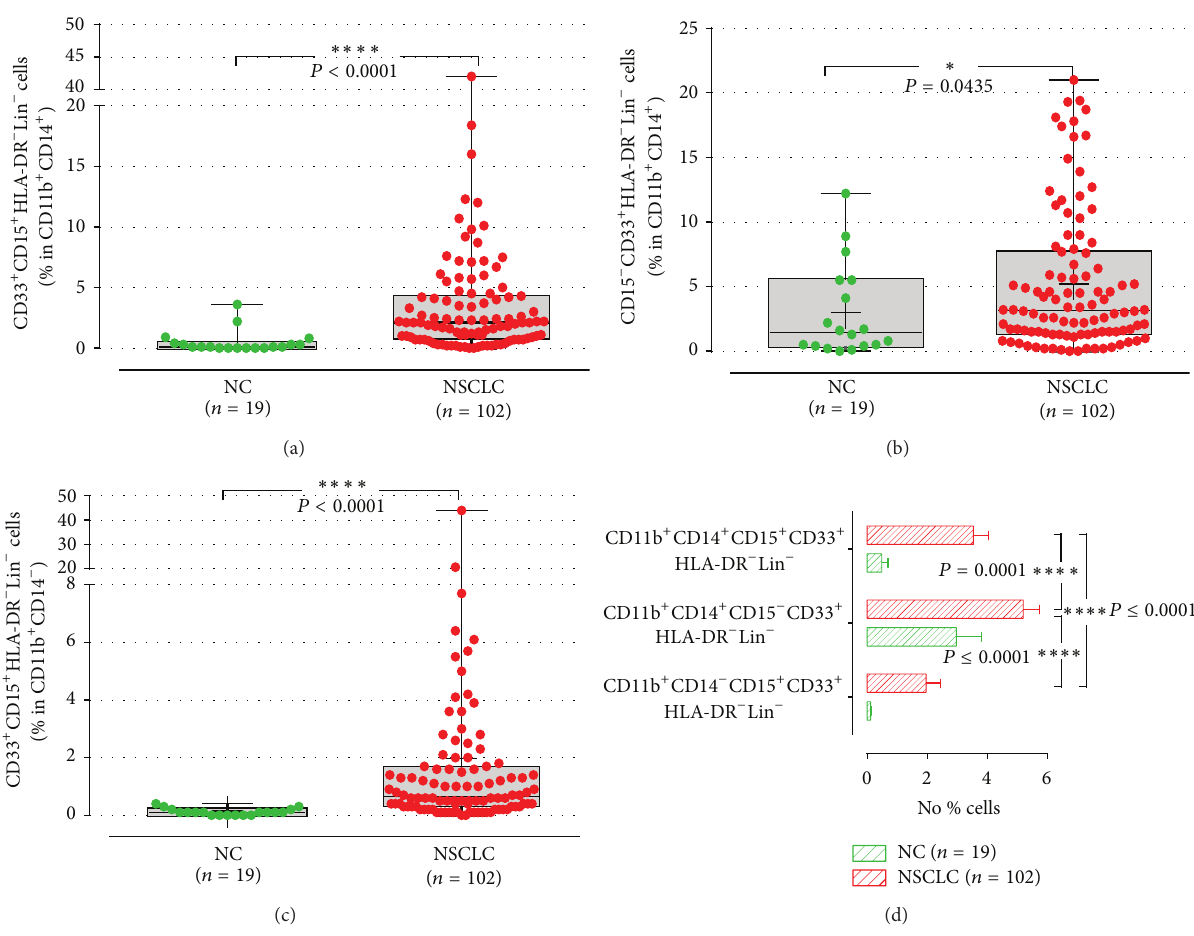
Figure2:M-MDSCandG-MDSCsubpopulationsinNSCLCpatientsandnormalcontrols.Percentageofmonocytic(a),(b),andgranulocytic (c) subpopulations of MDSCs in whole blood. Each point corresponds to an individual patient or healthy controls. The medians, 75 percentile (box), and max and min (whiskers) are represented. P values are determined by Mann-Whitney test (d). Comparison of the percentages between MDSCs subpopulations in the whole blood of the patients. Percentages indicated in the plots represent the percentages of phenotypic marker expression in the parental population, which are presented inside the brackets. The bars denote mean values ± SEM and the 𝑃 values are determined by Wilcoxon matched-pairs signed rank